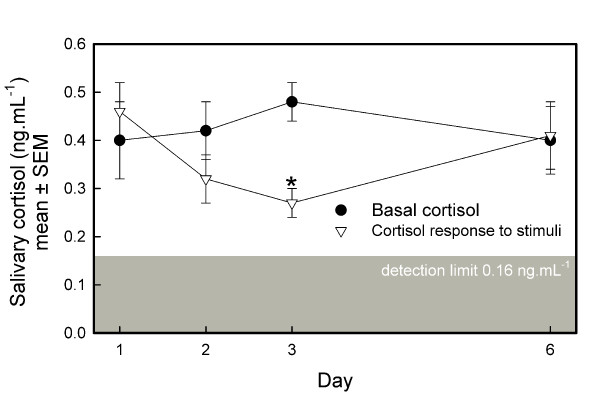
Daily basal salivary cortisol level and salivary cortisol response to stimulus presentations of 5 dairy goats. The daily baseline cortisol (ng.mL-1; mean ± SEM) was calculated as mean of the cortisol measurements preceding presentation of non-neutral stimuli (Table 1, last column), whereas the salivary cortisol response represents the mean of all cortisol measurements of a day, following the first stimulus presentation. *: One sample t-statistics on difference score between basal cortisol and cortisone response to stimuli, p < 0.05.